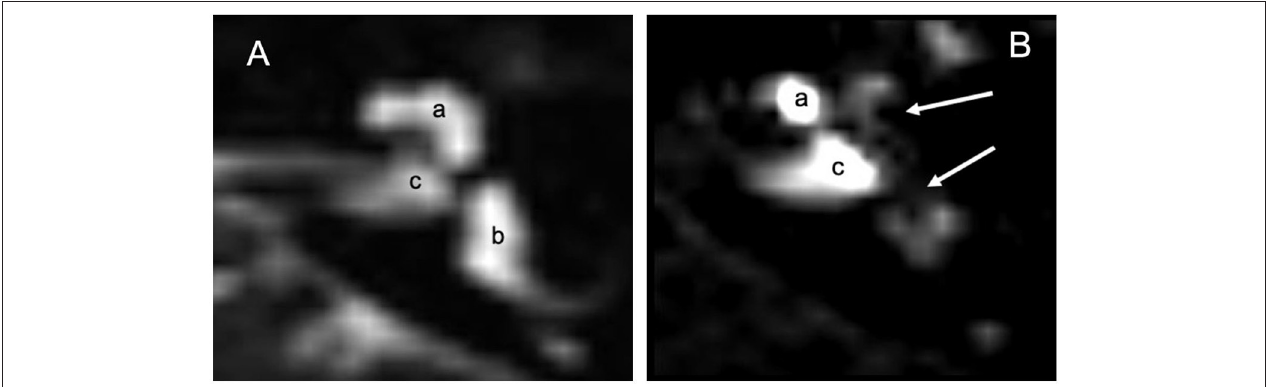
FIGURE 2 | MRI 3 Tesla: (A) MRI in T2 without contrast means: labyrinthine fluids including peri and endolymphatic spaces are observed (a) cochlea, (b) vestibular spaces and CSL and internal auditory canal (c). (B) 24h after infiltration with the Flair technique, the contrast shows absence of gadolinium in the apical gyrus of the cochlea and vestibule (white arrows). Gd illuminates part of the cochlea (a) and the internal auditory canal (c) which seems to be the main way of diffusion of gadolinium toward the liquor